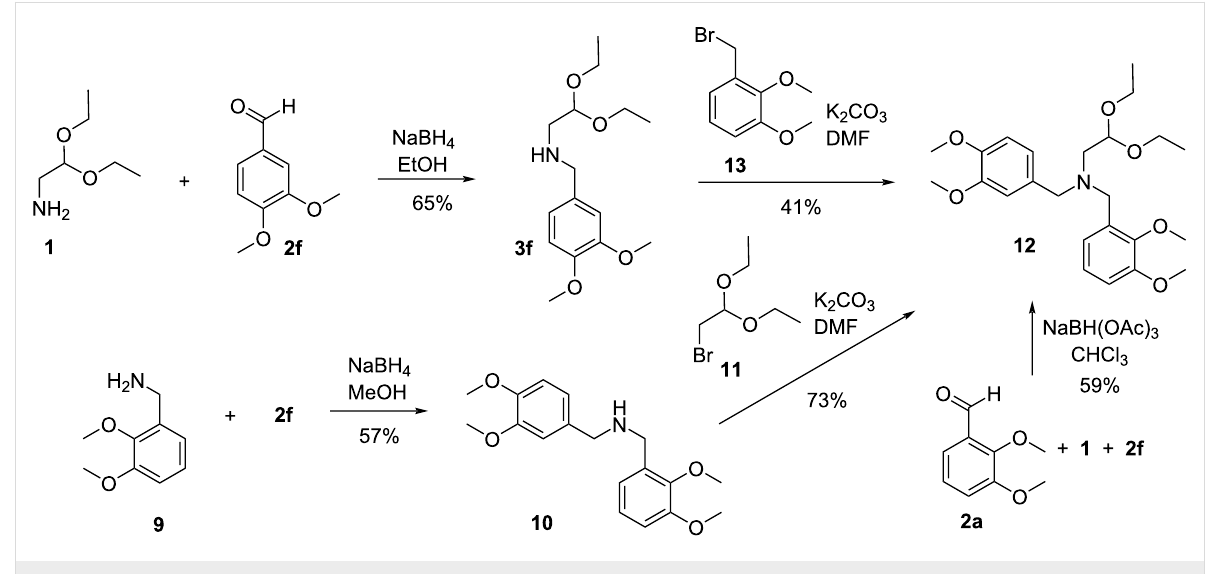
Scheme 8: Three pathways of the synthesis of 12 , the decarboxylated analogue of 6a